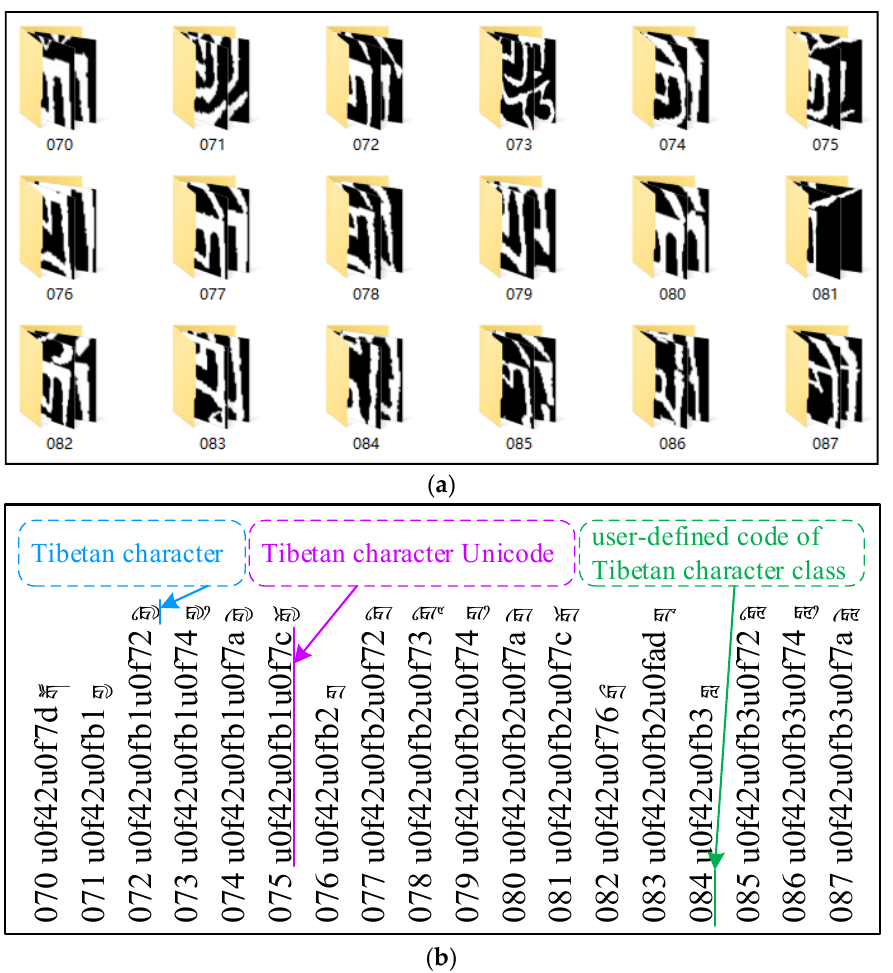
Figure 9. The constructed character dataset: ( a ) character images; ( b ) part of the character annotation mapping file (rotated 90 degrees to the right).